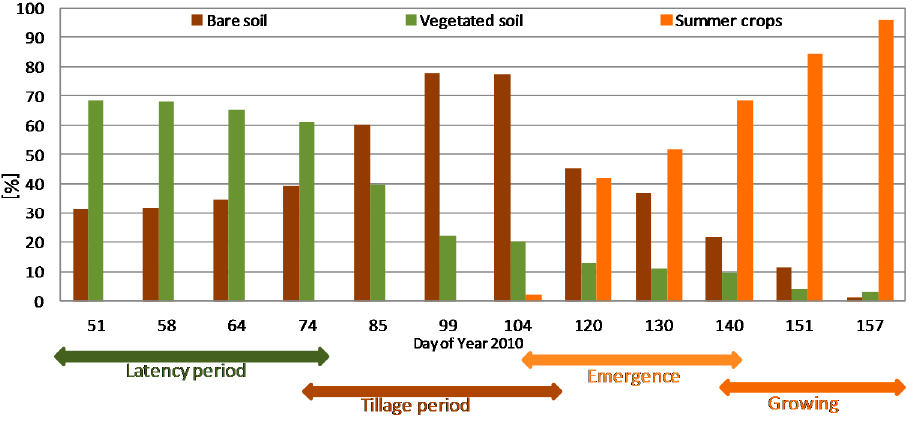
Figure 8. Time series of surface states of plots cultivated with summer crops in 2010, with an interval of about 10 days between each data point. Table 2. Description of the image dates used for each year.